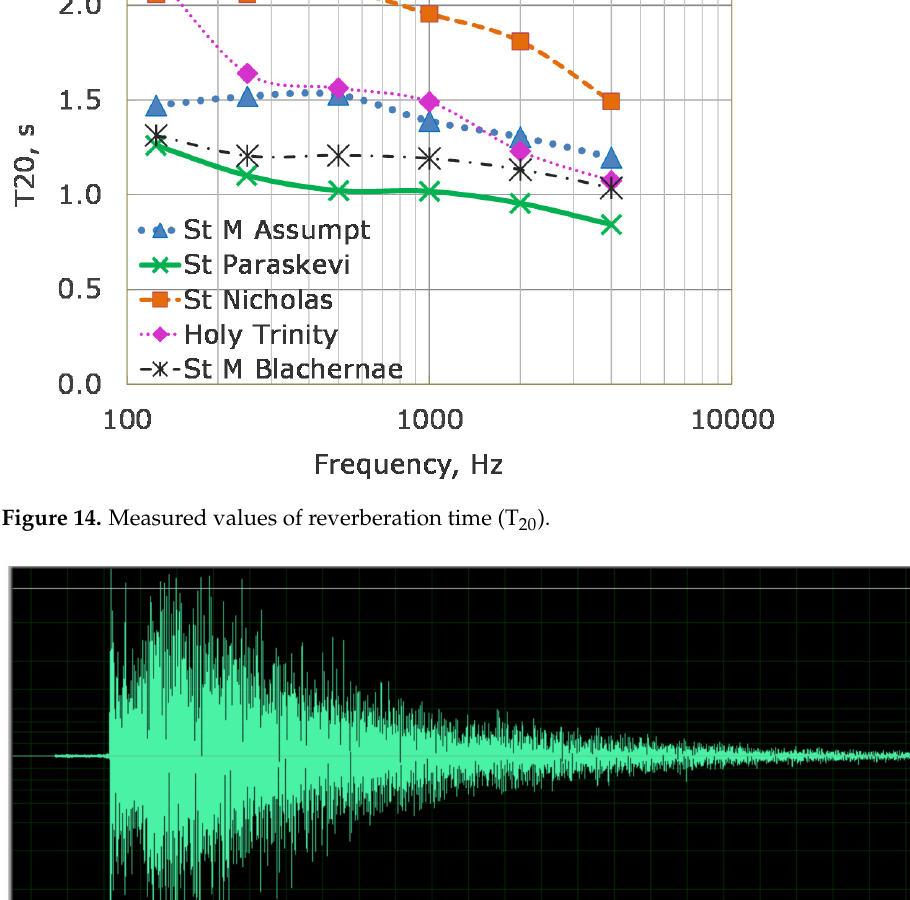
Figure 15. Impulse response measured inside St Nicholas’s church.